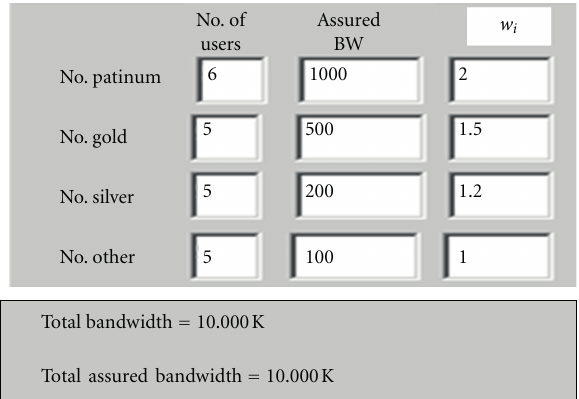
Figure 7: The system configuration in a simulation